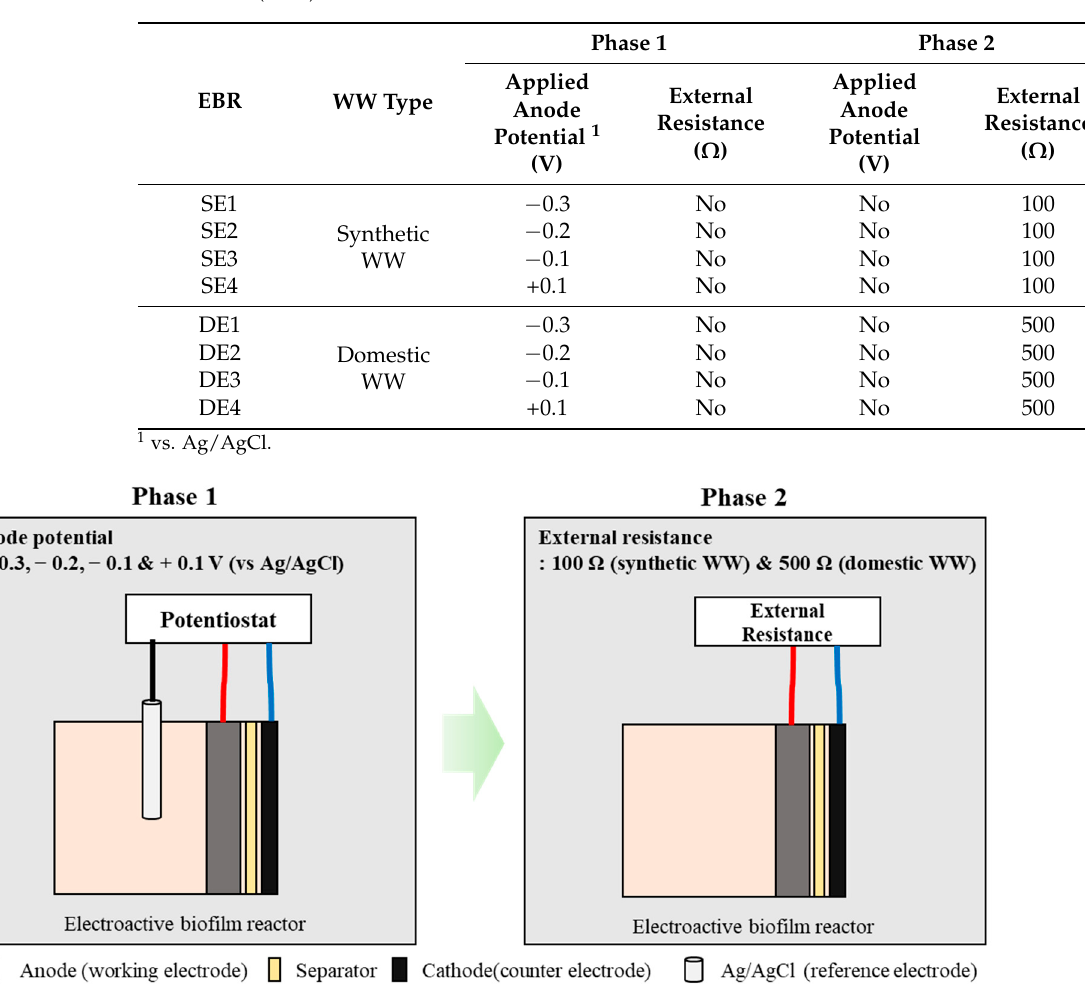
Table 1. Operating conditions of electroactive biofilm reactors (EBRs) treating synthetic and domestic wastewater (WW).